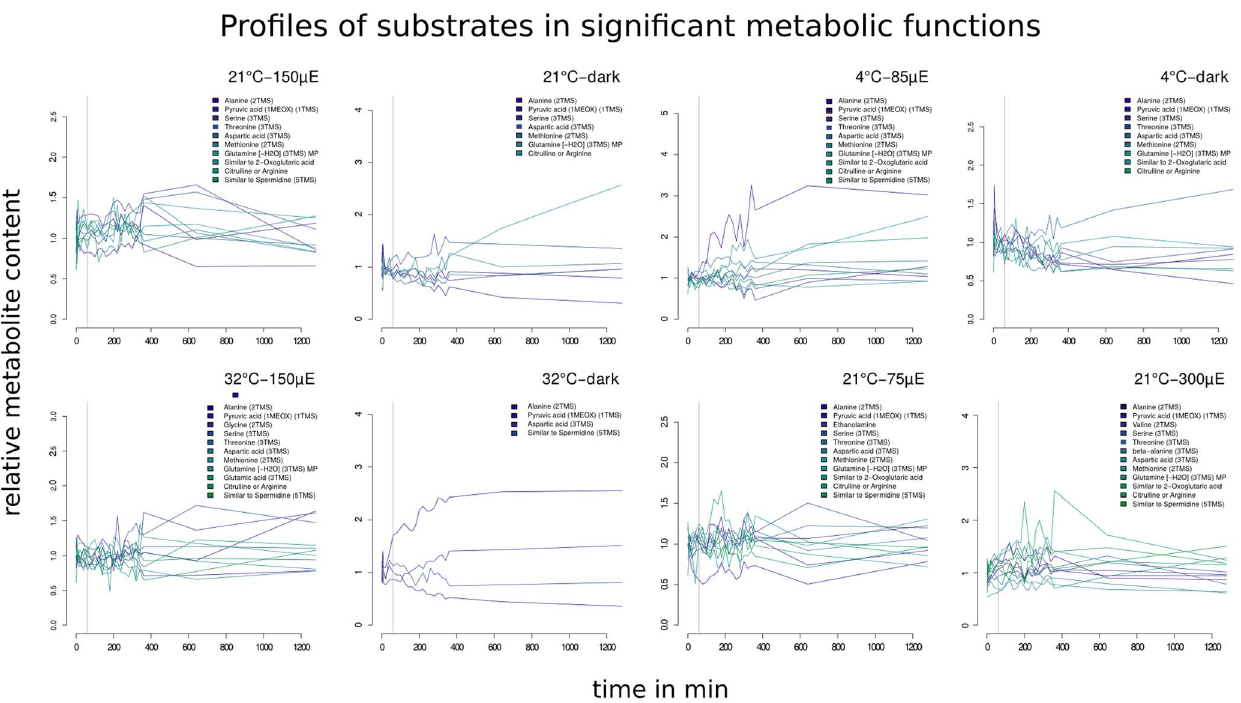
Figure 4. Time-series of the metabolites acting as substrates in differential metabolic functions. Profiles of the relative metabolite content of those measured metabolites that act as substrates in a pathway classified as differential with respect to the null model under the respective condition. The horizontal line indicates time point 60 minutes after stress application. All measurements before that time point were excluded from the analysis since they represent the phase of initial re-organization and transition into a new metabolic state.